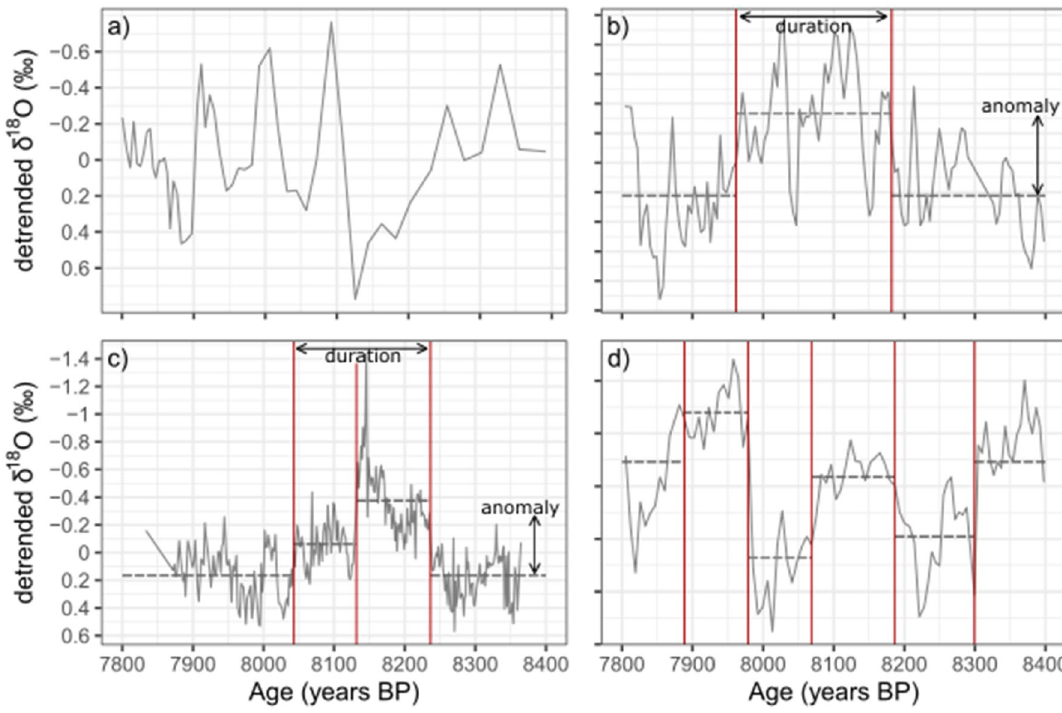
Figure 5. Detection of 8.2 ka isotope excursions. ( a ) shows a record (KOT-1 from Kotumsar cave 68 ) with no breakpoints and therefore no excursion, ( b ) shows a record (K1 from Katerloch cave 69 ) with an excursion constrained by 2 breakpoints, ( c ) shows a record (YD01 from Pippikin Pot 70 ) with an excursion constrained by > 2 breakpoints, ( d ) shows a record (So-1 from Sofular cave 71 ) with > 2 breakpoints, but isotope excursions of varying direction and therefore no clear 8.2 ka